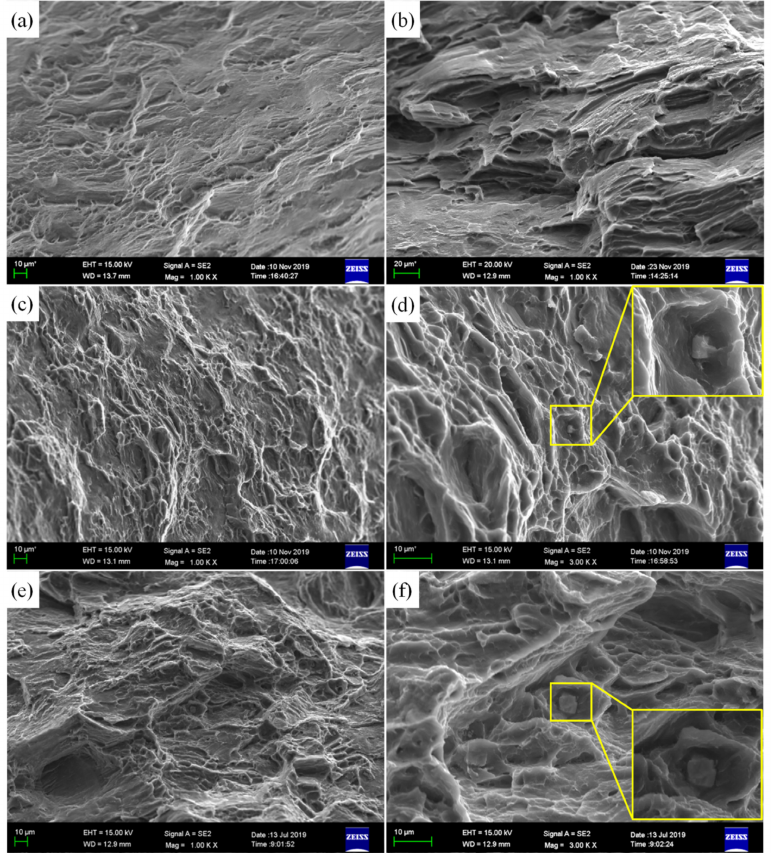
Figure 24. SEM micrographs of the fracture surface of ( a ) as-rolled and ( b ) as-annealed pure Mg sheets; ( c , d ) as-rolled and ( e , f ) as-annealed Mg-3Y